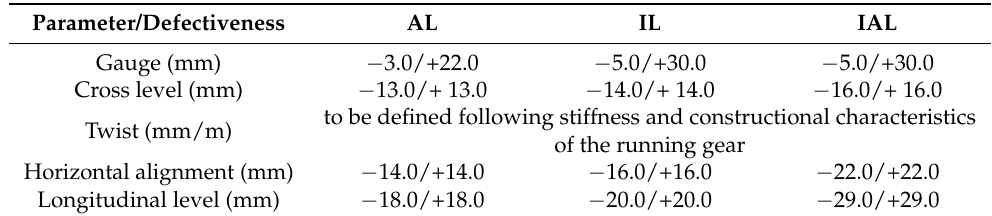
Table 3. Alert Limits (AL), Intervention Limits (IL), and Immediate Action Limits (IAL) according to the Urban Track project